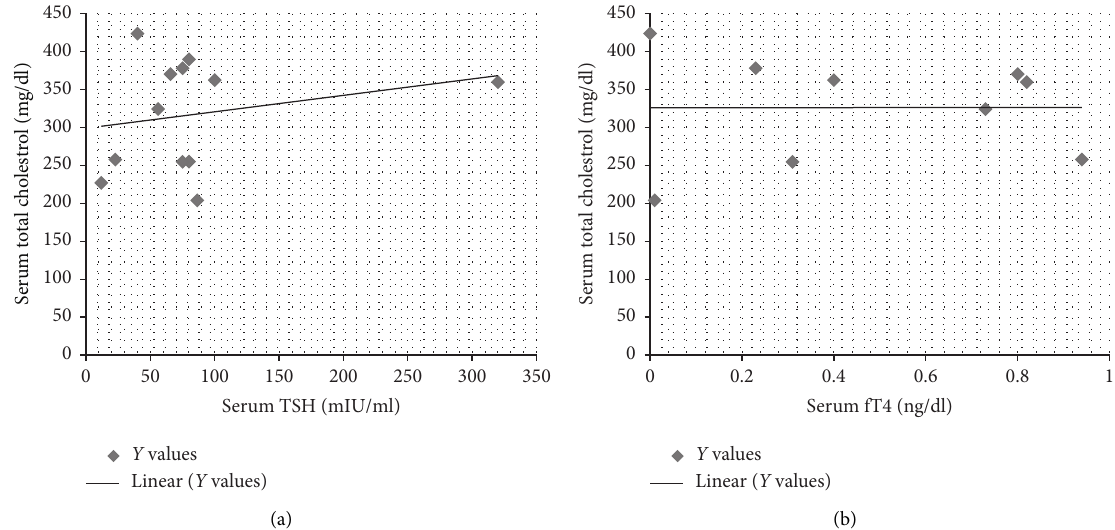
Figure 4: Correlation between serum TSH, fT4, and total cholesterol in clinical studies. fT4, free thyroxin; TSH, thyroid-stimulating